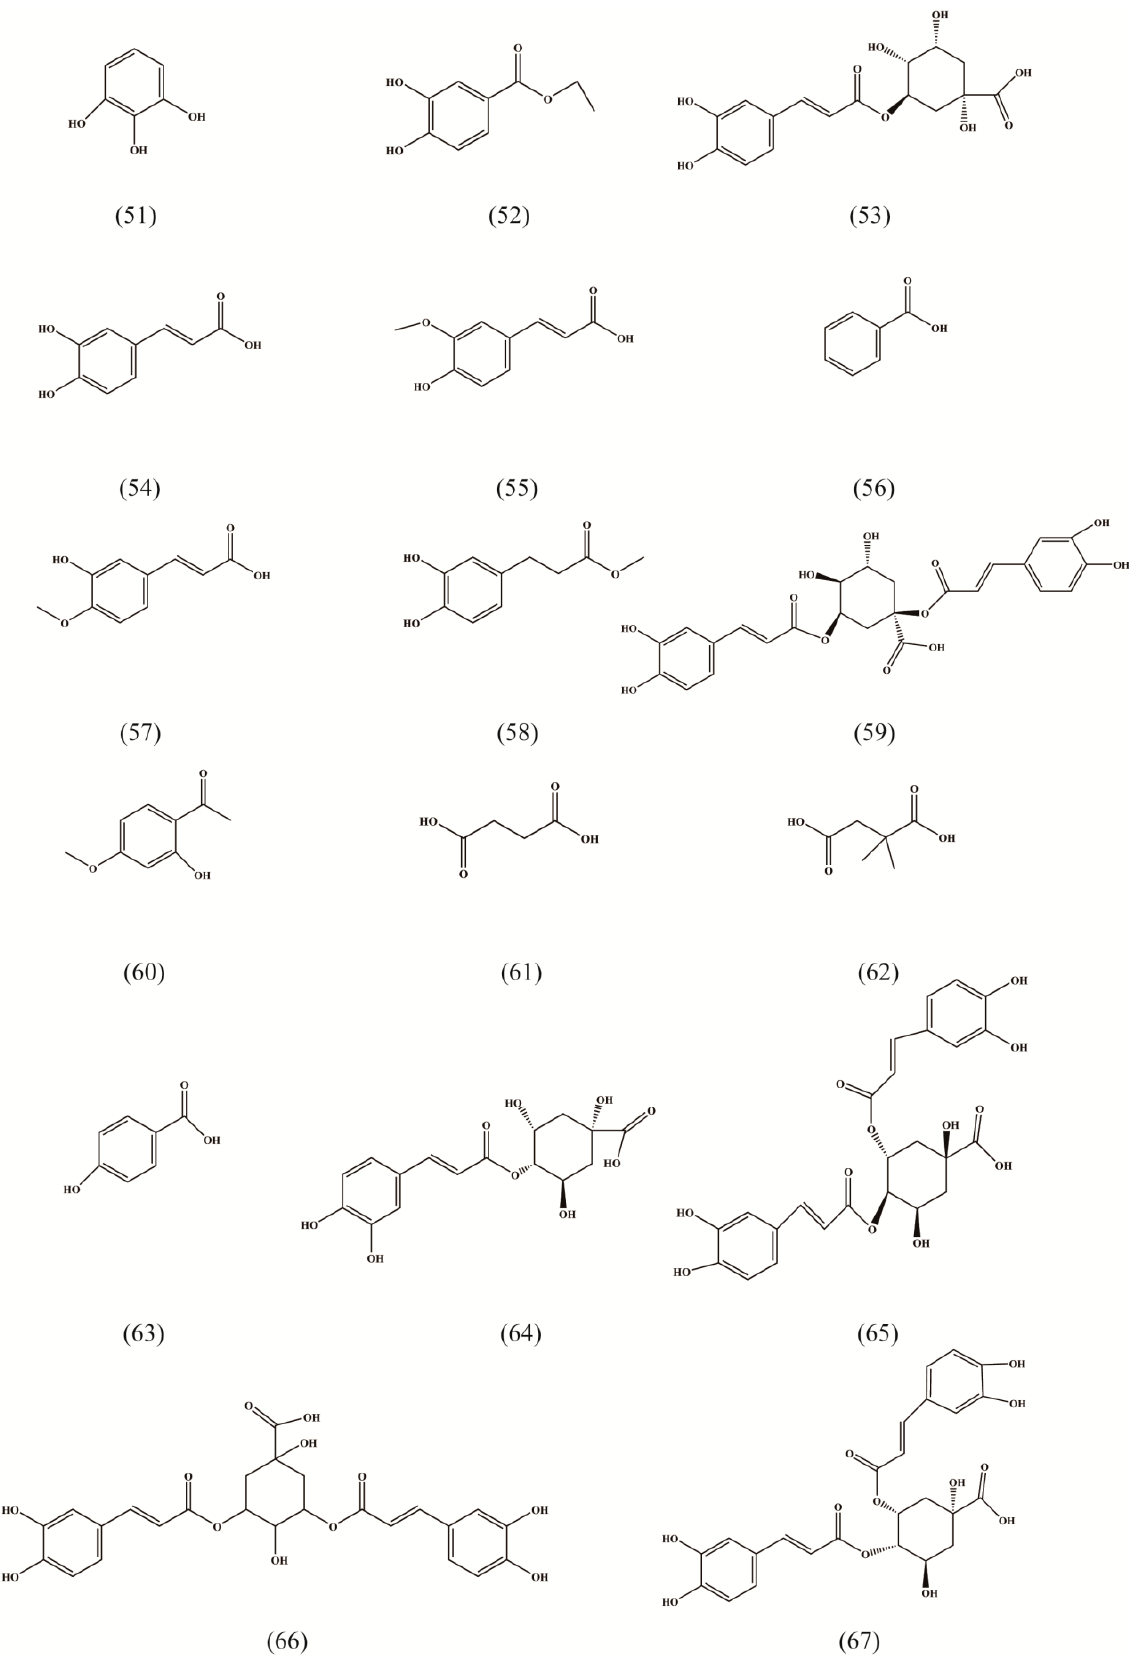
Figure 3. Structures of organic acids isolated from Radix Asteris.